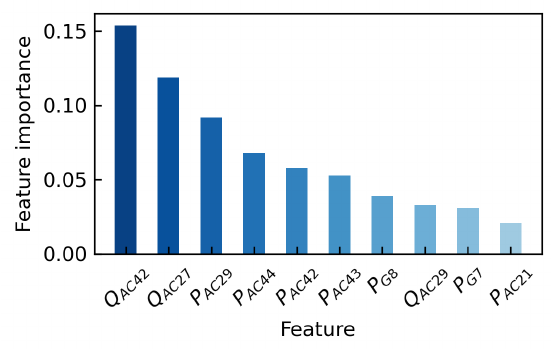
Figure 4. Impurity-based M-FIA for the DSA-DL model.